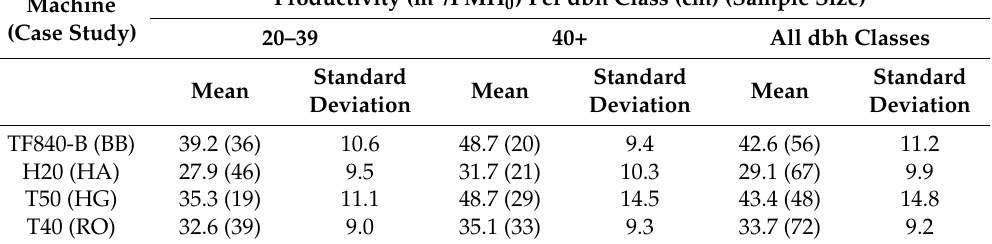
Table 7. Mean harvesting productivity and standard deviation per dbh class for the four machines (case studies) in the fully-mechanized (FM)